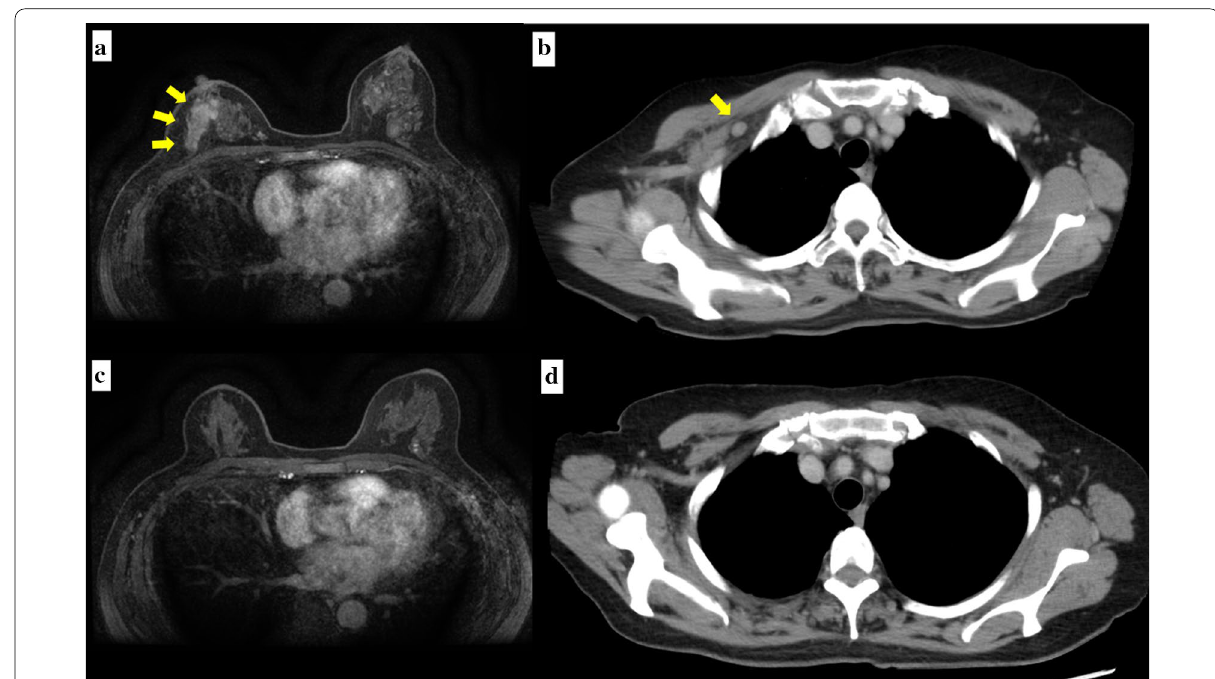
Fig. 3 a MRI (T2-weighted image) showed a high-signal mass in the right breast before chemotherapy. b CT showed a swollen axillar lymph node before chemotherapy. c MRI (T2-weighted image) showed that the mass had disappeared after chemotherapy. d CT showed that the lymph node had disappeared after chemotherapy